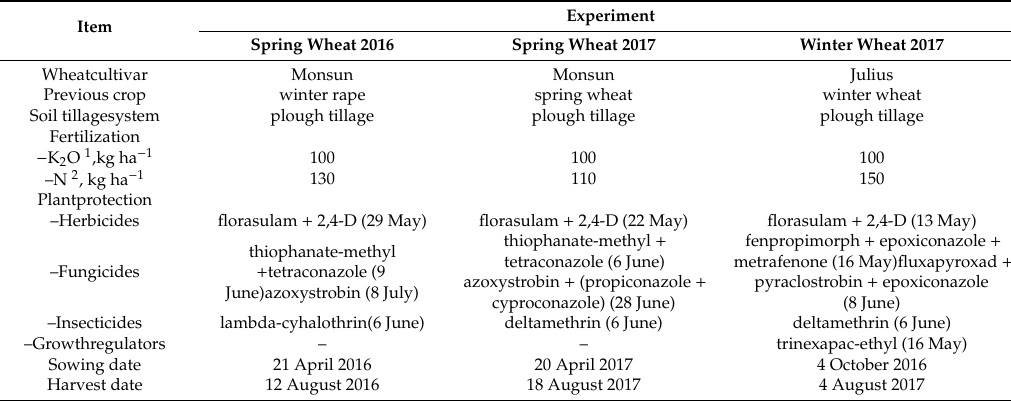
Table 5. Basic agricultural data for the